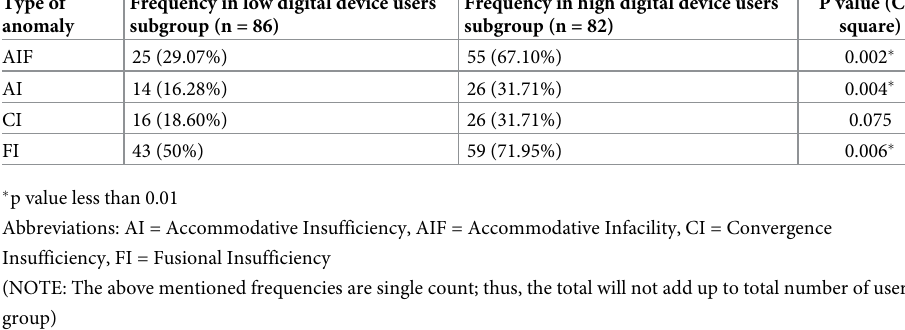
Table 5. Comparison of prevalence of accommodative and vergence anomalies between low and high digital device users subgroups. Type of